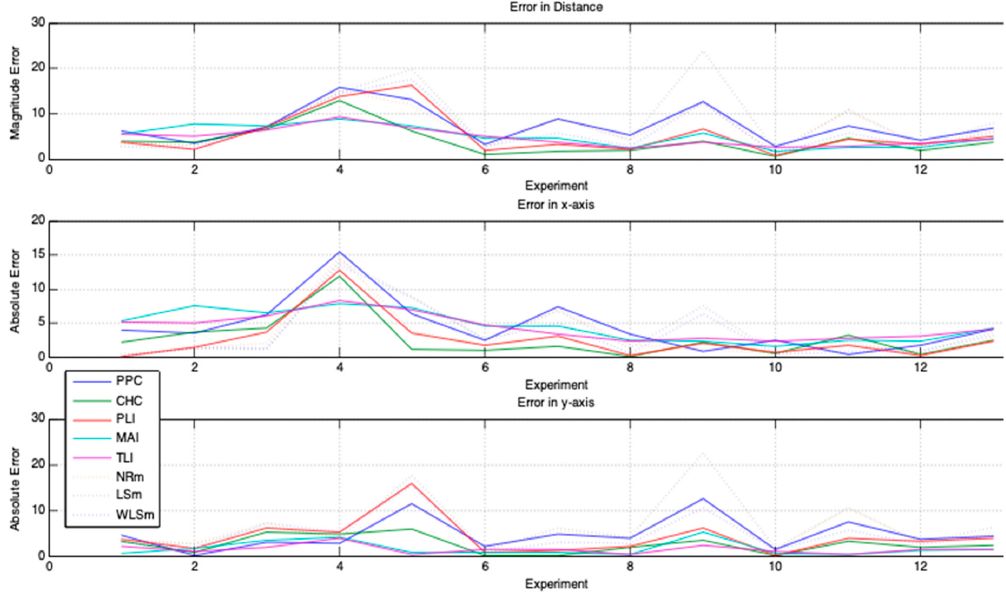
Figure 16. Magnitude error analyses.